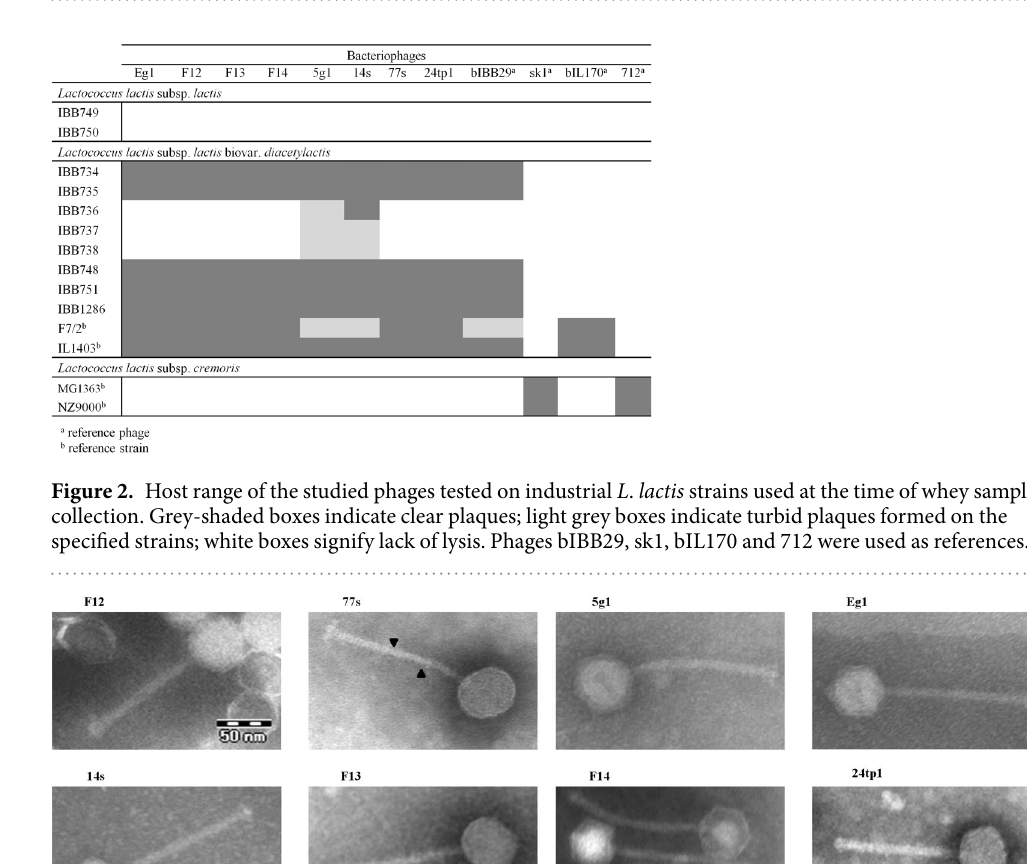
Table 2. Burst size, burst time and latent period based on one-step growth assay of the studied phages. Values are the means of three determinations ± standard deviations.